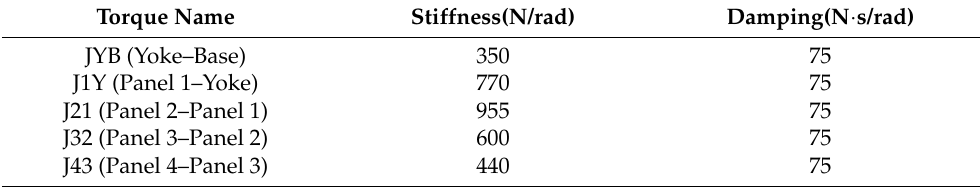
Figure 4. Nonlinear stiffness spline of single TSH. Table 2. Structural parameters of torsion spring.